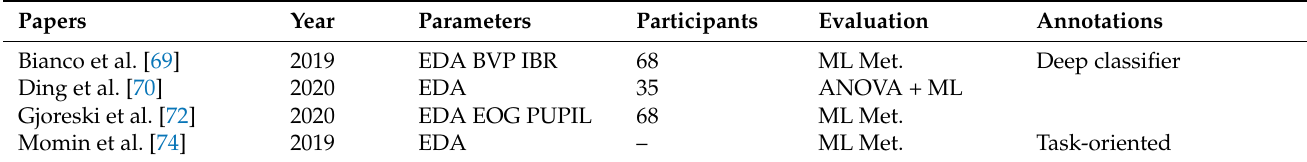
Table 8. Physiological signals used in task-oriented experiments.